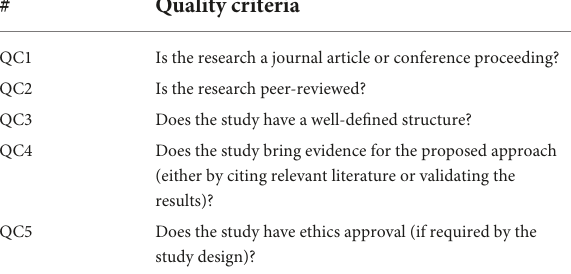
TABLE 2 Quality